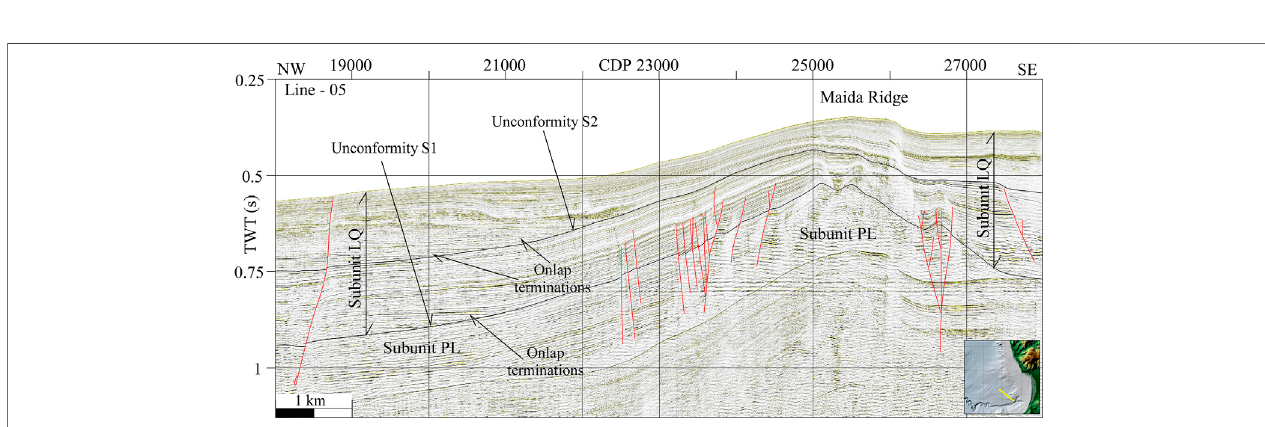
FIGURE 7 | Seismic pro fi le “ Line — 05 ” and its interpretation. Inset shows the location of the pro fi le. PL and LQ are the subunits recognised in the Plio Quaternary deposits. Red lines indicate transtensional faults.